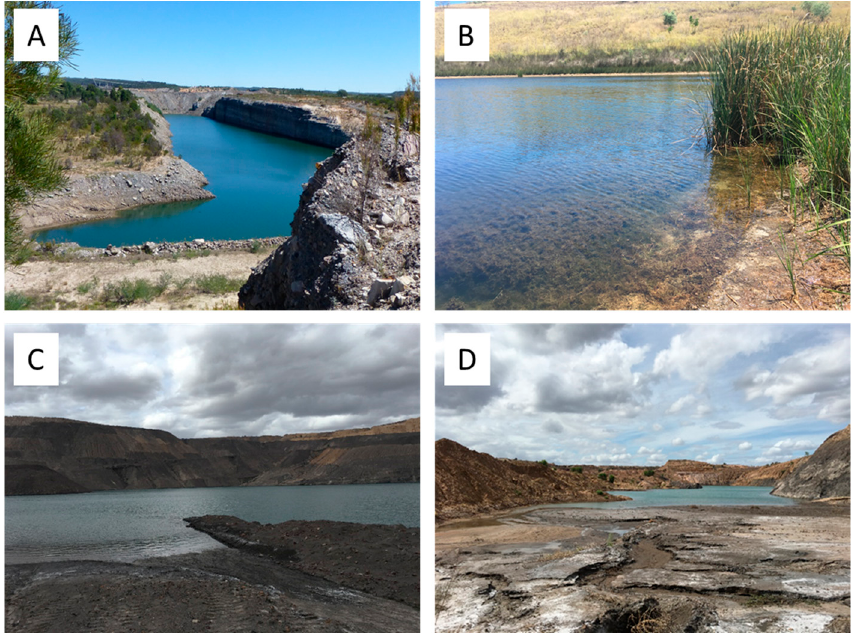
Figure 2. Photographs of Australian mine pit lakes. ( A ) Hunter Lake 1 (HL1), ( B ) Hunter Lake 2 (HL2), ( C ) Bowen Lake 1 (BL1) and ( D ) Bowen Lake 2 (BL2). Hunter Lakes 1 and 2 are approximately 200 km apart in a geographical line.